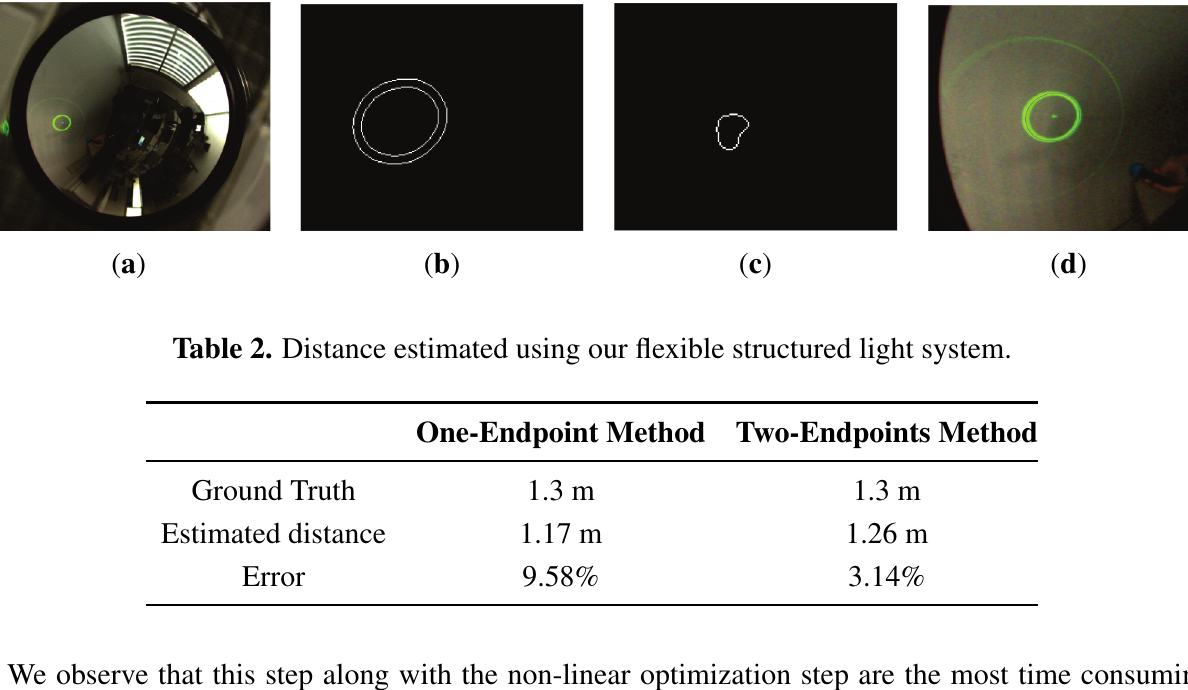
Figure 11. ( a ) Original image; ( b ) Pattern light extracted; ( c ) Laser endpoint extracted; ( d ) Light pattern detection.